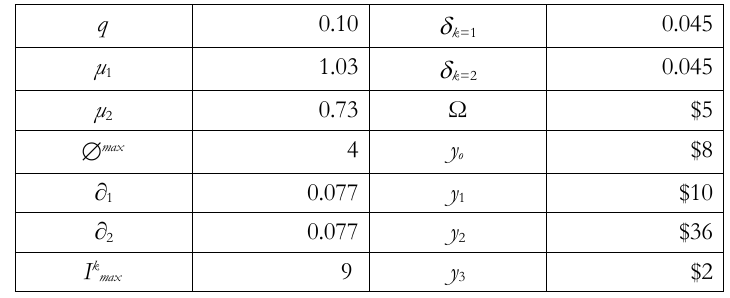
Table 3. Common input parameters